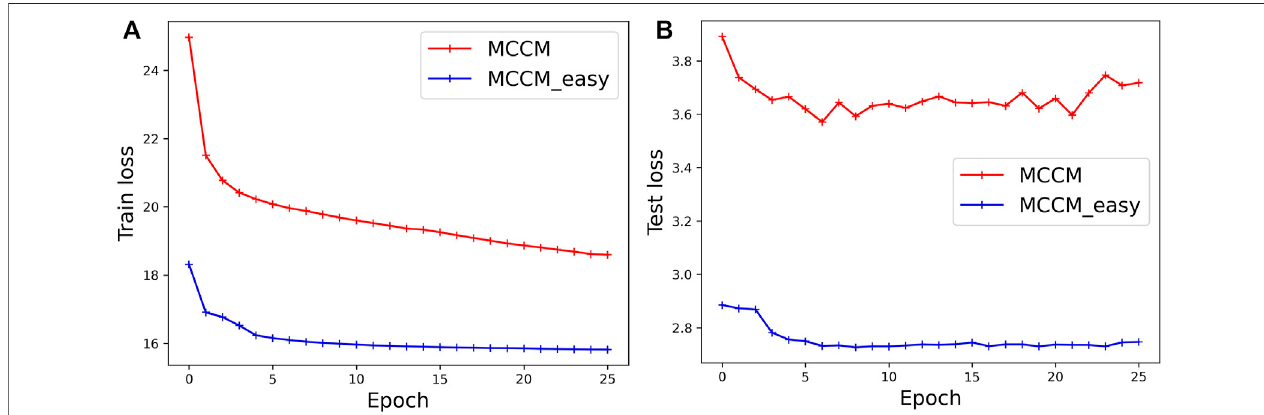
FIGURE 3 | The loss value computed on the training and test datasets.